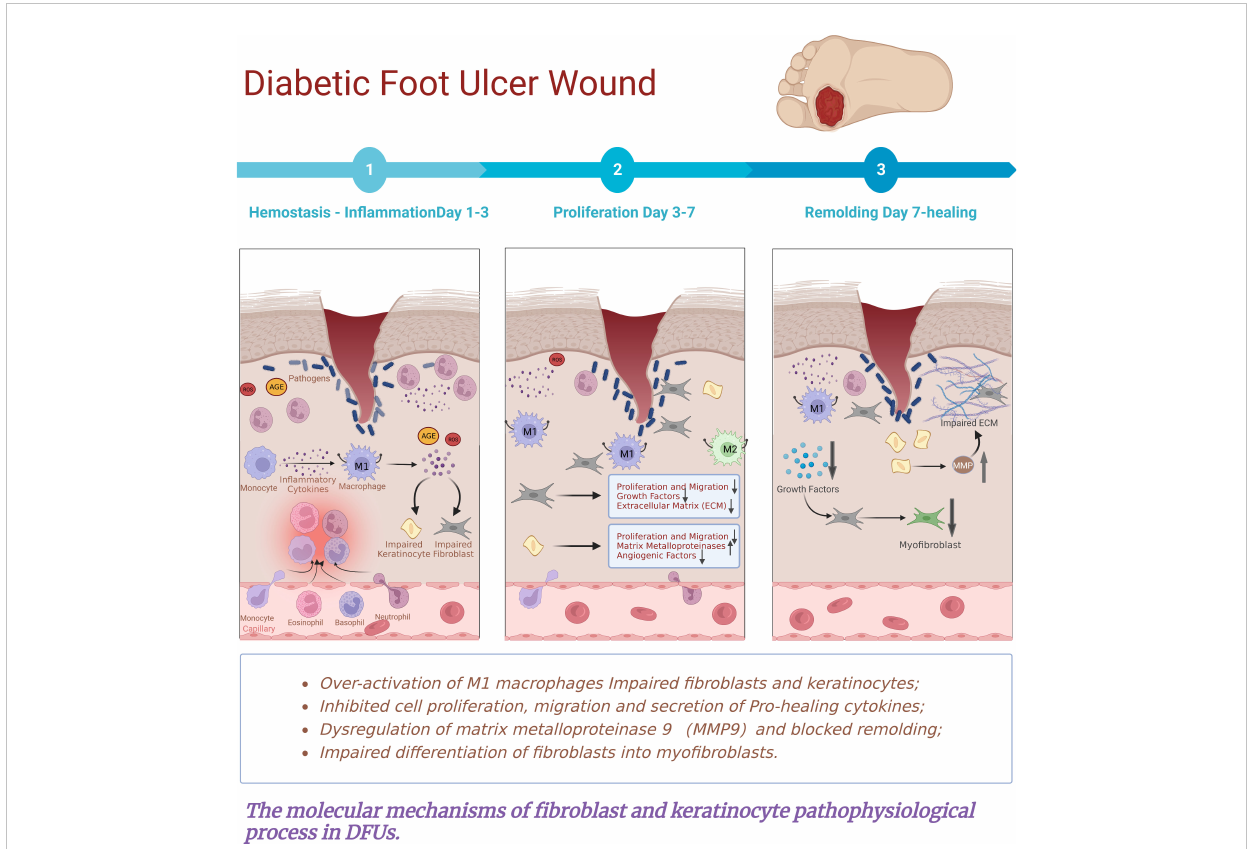
FIGURE 6 The molecular mechanisms of fi broblast and keratinocyte pathophysiological process in DFUs.The persistent non-healing of DFU wounds is the result of a combination of factors leading to a constant and excessive chronic in fl ammatory response. In the microenvironment of diabetic wounds, perturbations are associated with hyperglycaemia, advanced glycation end products, oxidative stress and impaired angiogenesis. These factors comprise impaired fi broblasts and disruption of their proliferation, migration, secretion of extracellular matrix and differentiation into myo fi broblasts. Meanwhile, there is keratinocyte migration and proliferation, reduced angiogenesis, chronic In fl ammation, and abnormal expression of MMPs. Resulting in a constant and excessive chronic in fl ammatory response, disrupting epithelial cell formation and eventual wound closure. Ultimately leading to the development of chronic non-healing